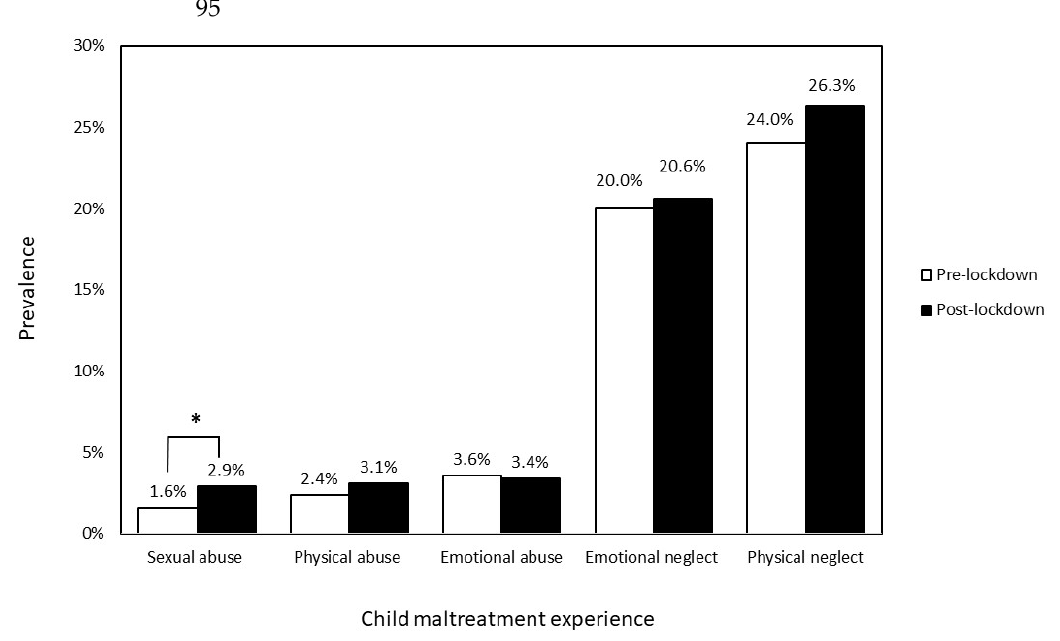
Figure 1. The prevalence of child maltreatment pre- and post-lockdown. * Bonferroni correction p < 0.05, data shows percentage and percentage error. Table 2. Mixed model predicting an increase in sexual abuse from before to after lockdown.